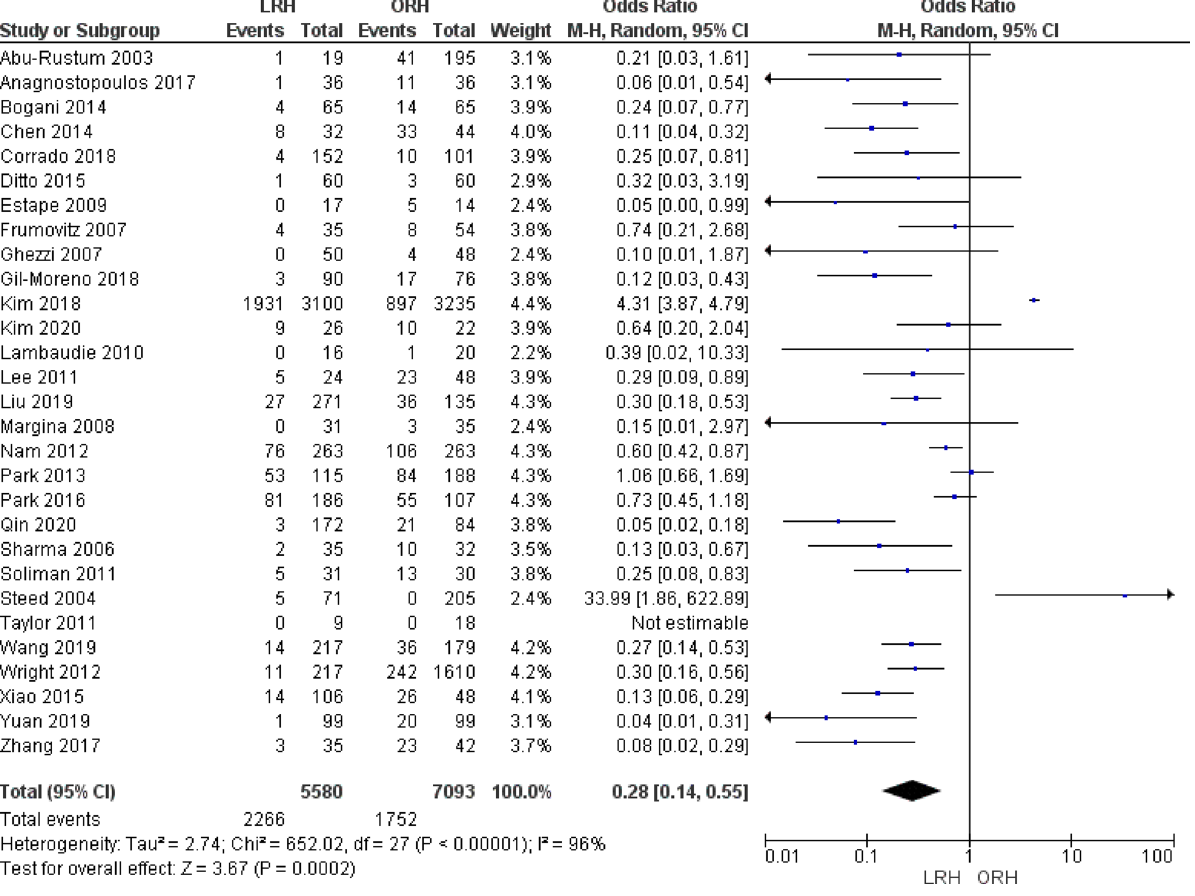
Figure 12. Forest plot of the rate of blood